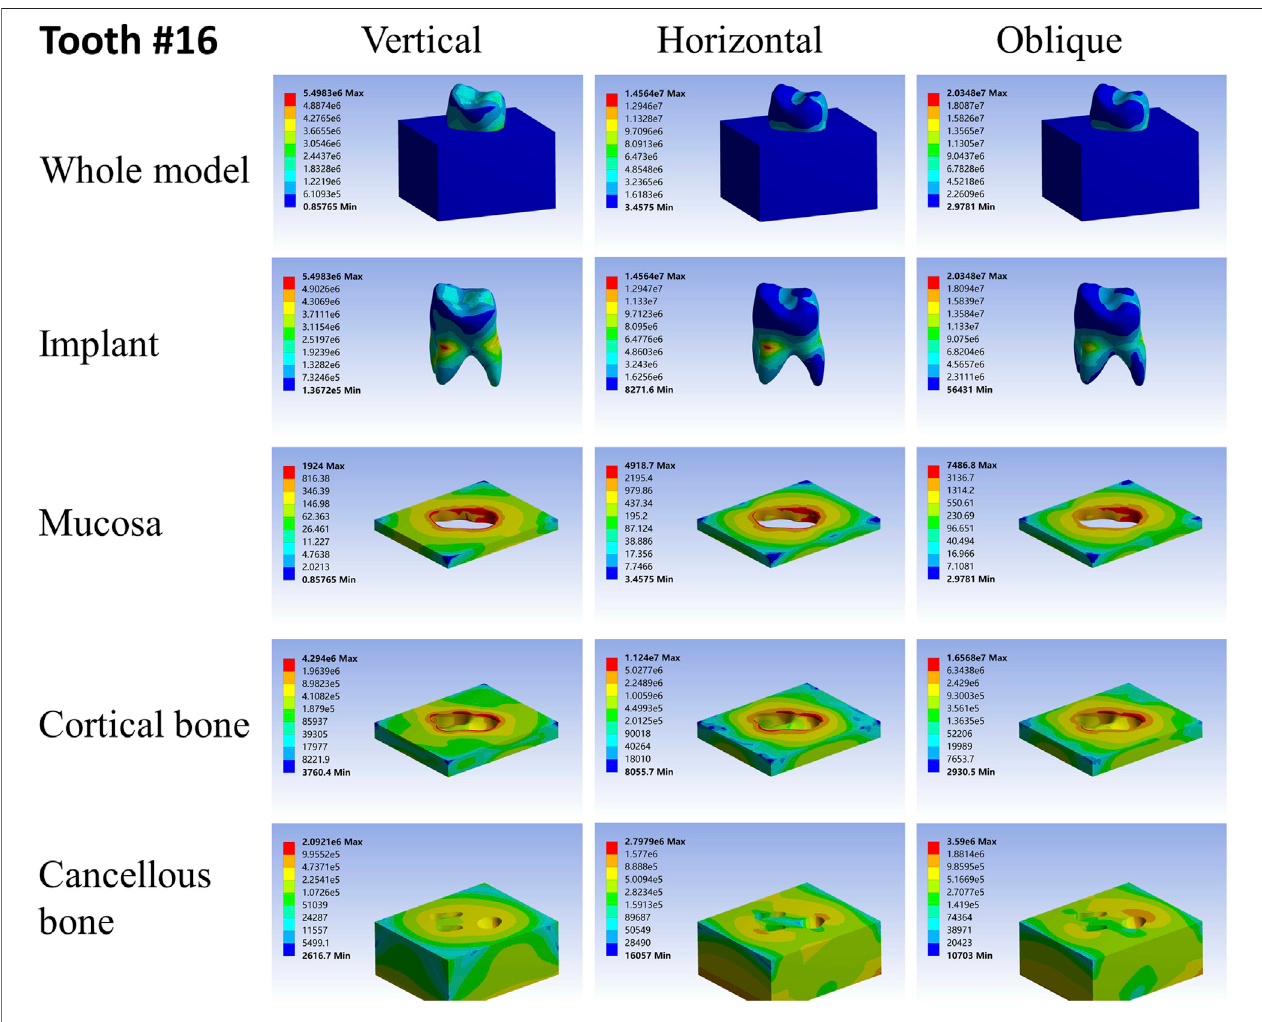
FIGURE 2 | Stress distribution of 26 under 100-N